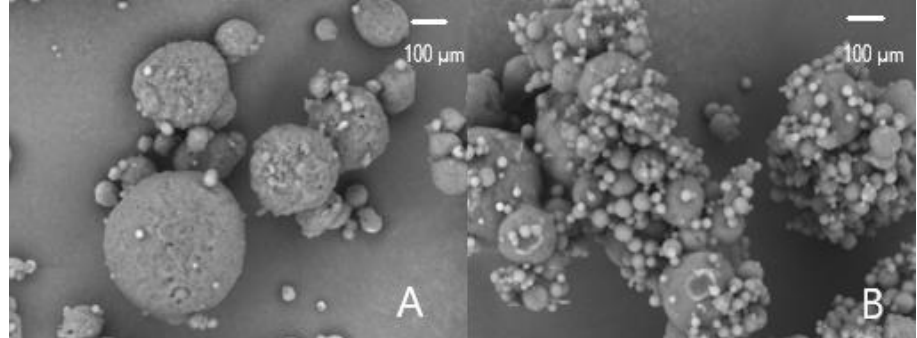
Figure 1. Scanning electron micrographs (1000× magnification) of SC-40 ( A ) and SDC-15 ( B ). SC-40: particles produced in the spray-chiller with 40% extract; SDC-15: particles produced in the spray-chiller with 15% spray-dried particles.